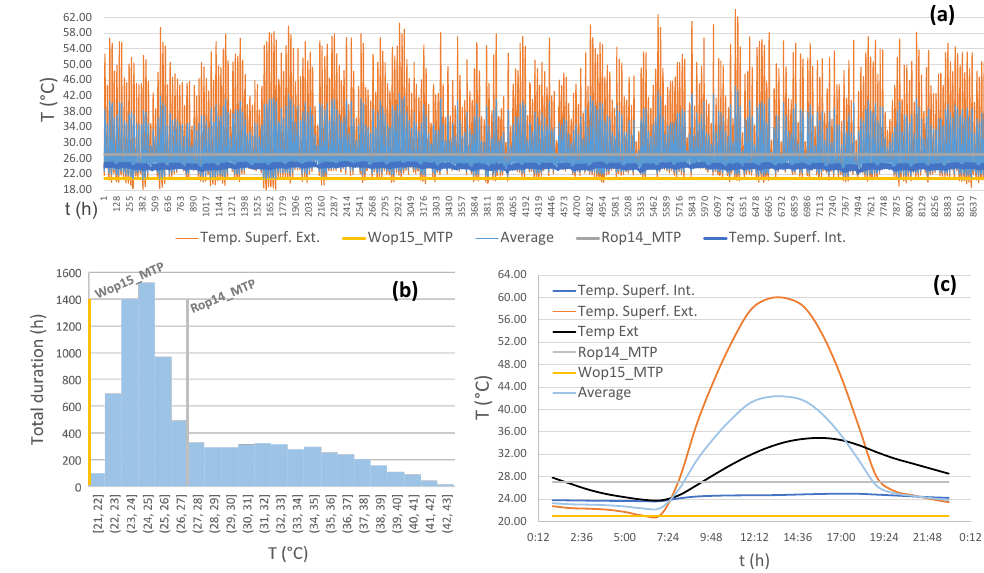
Figure 14. Local results from simulations for OB: ( a ) hourly temperatures for the entire year, ( b ) duration-based frequency for average temperature, and ( c ) hourly temperatures on 18